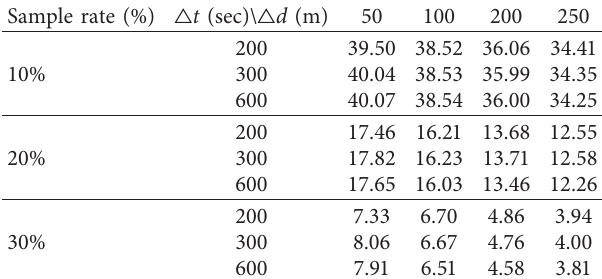
Table 5: MAPE by sample rate, unit section, and unit time of scenario 2 (numerical